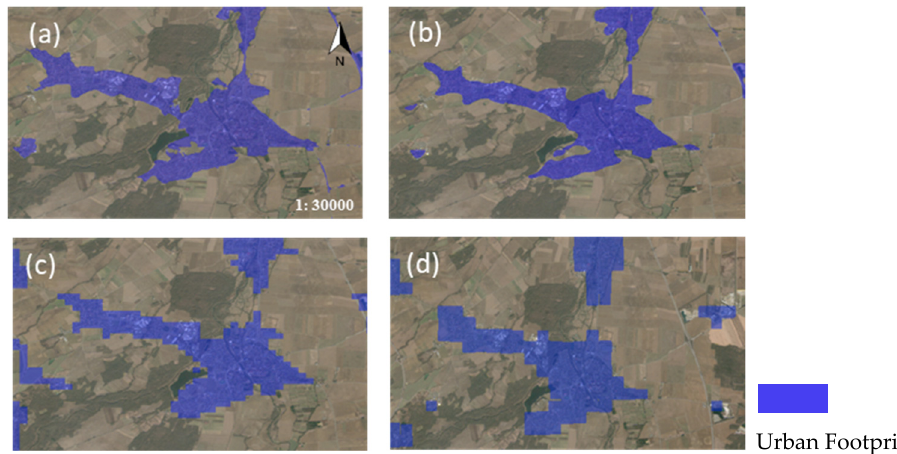
Figure 11. The class of urban footprint (in blue) as predicted by each model at a scale of 1/30000: ( a ) UNet prediction; ( b ) SegNet prediction; ( c ) FCN-16s prediction; ( d ) FCN-32s prediction.